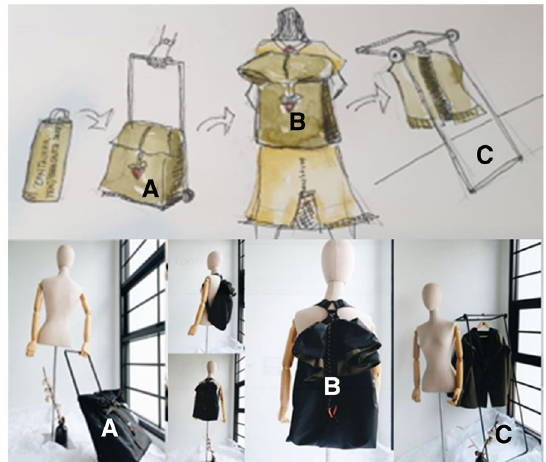
Fig. 3 The tent is in a Travel bag that transforms into a Jacket and interior accessories. Source: authors and (Lianto et al. 2021). A Small and practical tents can be put into the Travel bag. B Travel bag can be a Backpack and can be transformed into a unisex jacket. C This jacket is adapted to the needs of space for one person and interior